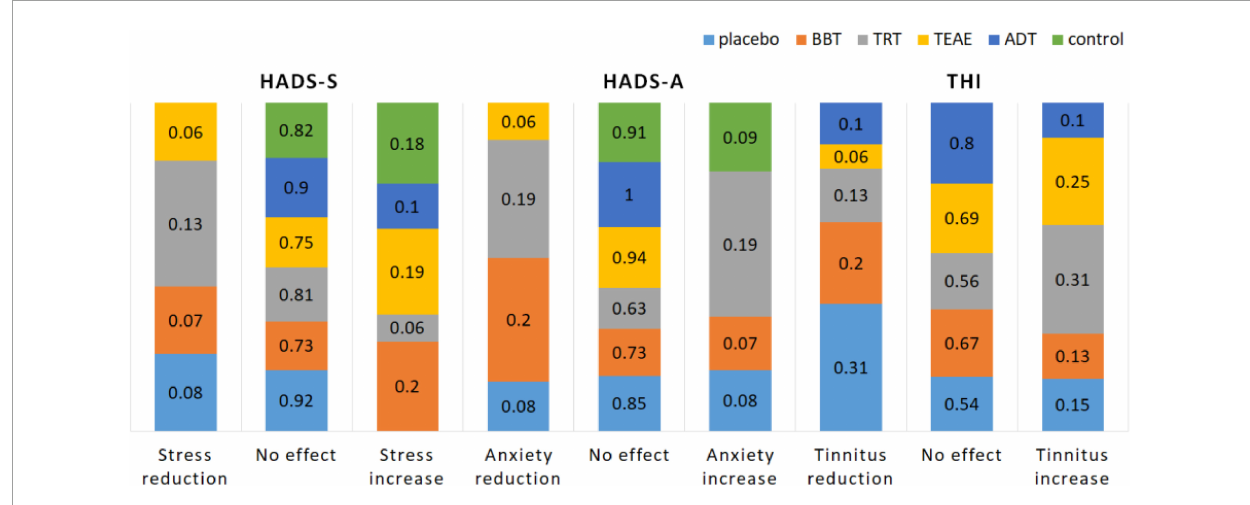
FIGURE7 Psychological evaluation of acoustic therapies based on the monitoring of three factors: stress (HADS-S), anxiety (HADS-A), and tinnitus perception (THI).